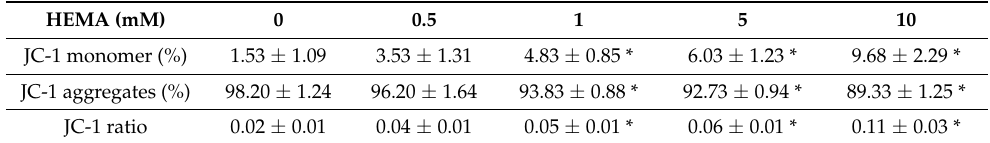
Table 2. The parameters of mitochondrial dysfunction in RAW264.7 macrophages exposed to the different concentrations of HEMA for 24 h via JC-1 staining.